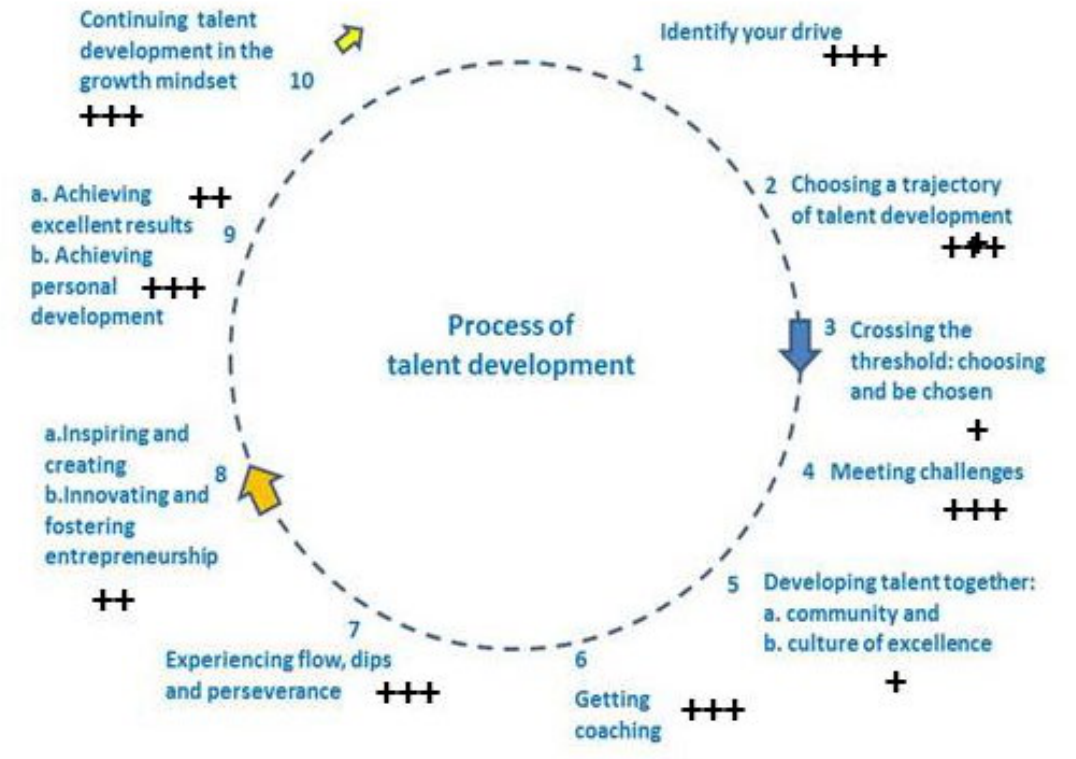
Figure 1: Circle of Talent Development in relation with the good practice ‘Students present personal learning journey’ with the teacher’s